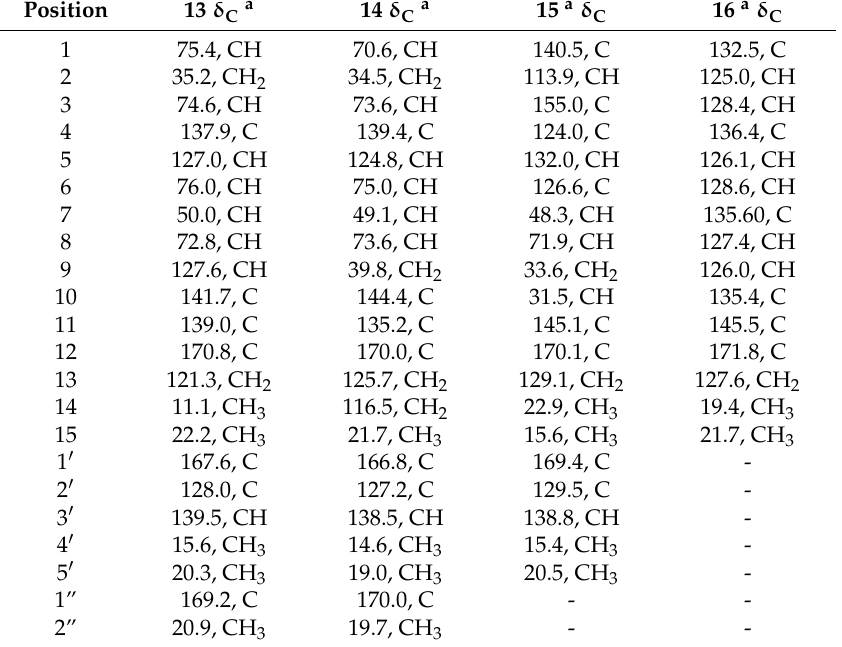
Table 4. 13 C-NMR spectroscopic data for compounds 13 – 16 (CD 3 OD; 125.77 MHz; δ in